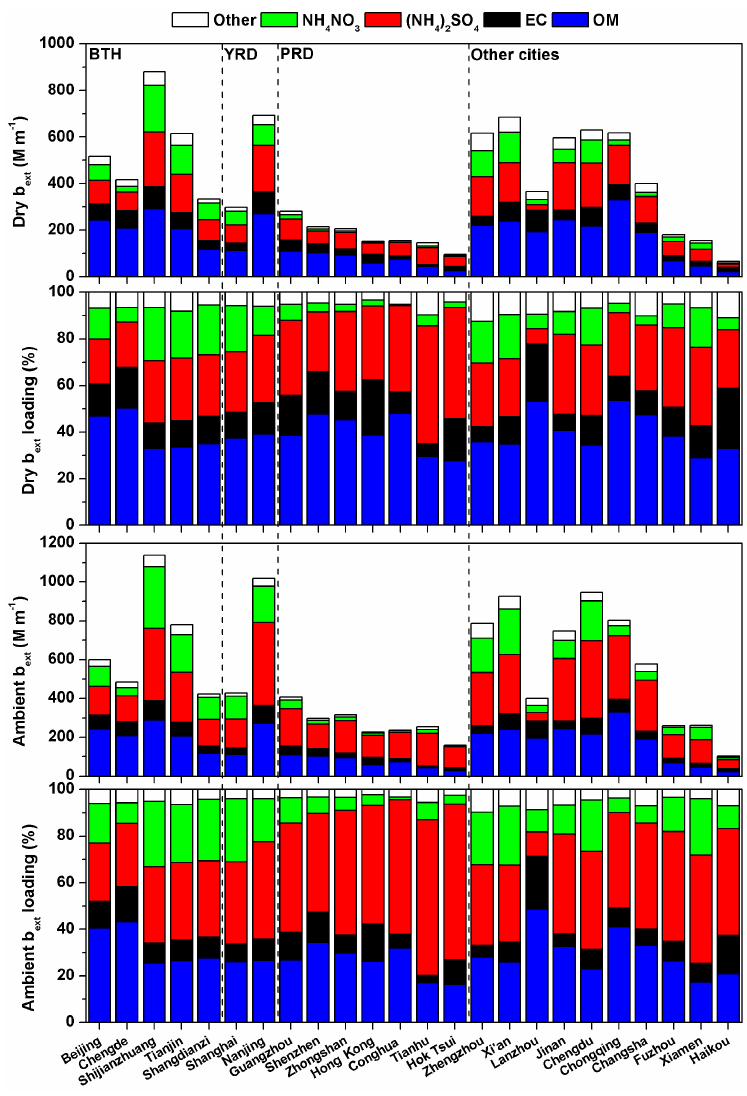
Figure 16. Annual b ext percentage loading under dry and ambient conditions at urban sites in